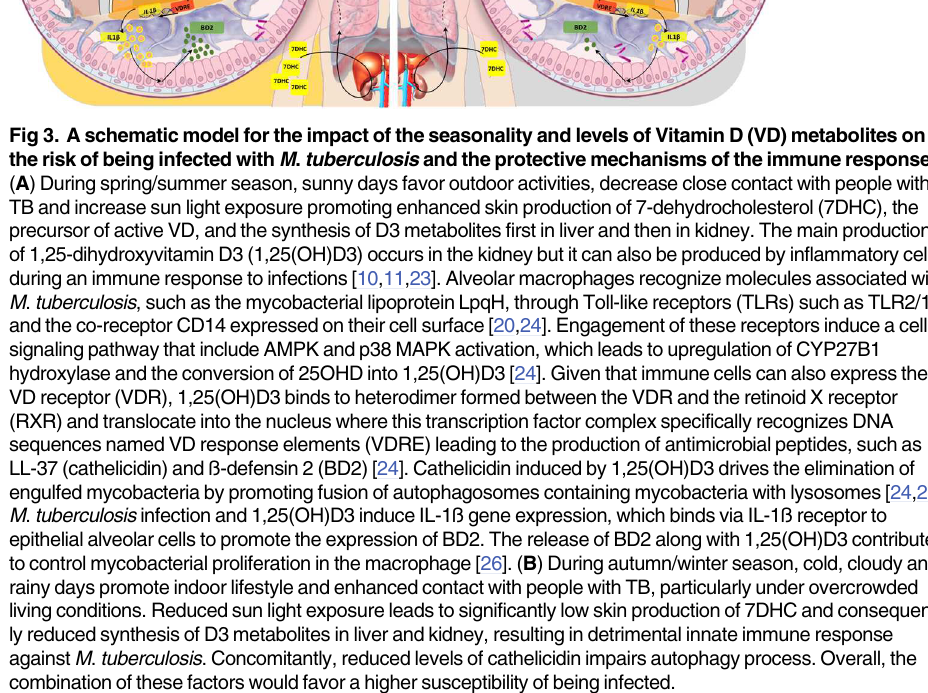
a combination of higher environmental bacterial load exposure as well as an impaired capacity of innate immune system to clear this intracellular bacterium associated to low levels of circu- lating 25OHD ( Fig 3 ). In effect, activation of macrophages via toll-like receptors (TLR) and interferon-gamma are key components of the immune response to M . tuberculosis that are proposed to be 1,25(OH)D3 dependent [20,21]. In macrophages, 1,25(OH)D3 binds to the vitamin D receptor (VDR) inducing the production of β -defensin 2 and the antimicrobial pep- tide cathelicidin, that induces autophagy and reversal of phagosome maturation arrest, favor- ing therefore M . tuberculosis killing and facilitating antigen processing [22]. Besides, activation of macrophages via TLR leads to upregulation of VDR and upregulation of the enzyme CYP27B1 which converts 25OHD to its active form 1,25(OH)D3. Therefore, under low plasma 25OHD concentrations phagocytosis may be impaired and M . tuberculosis infection not cleared, adding to the condition of a higher mycobacterial load in the environment due to lon- ger indoor periods, decreased household ventilation, and low UV exposure naturally occurring in winter.